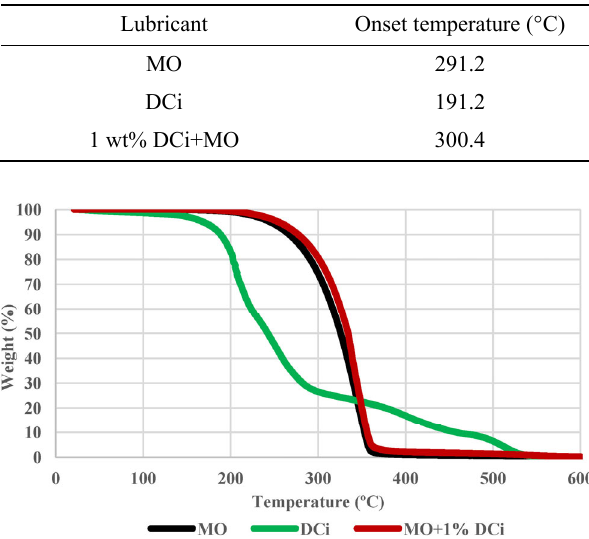
Table 3 Thermal stability of MO, DCi, and 1 wt% DCi+MO.